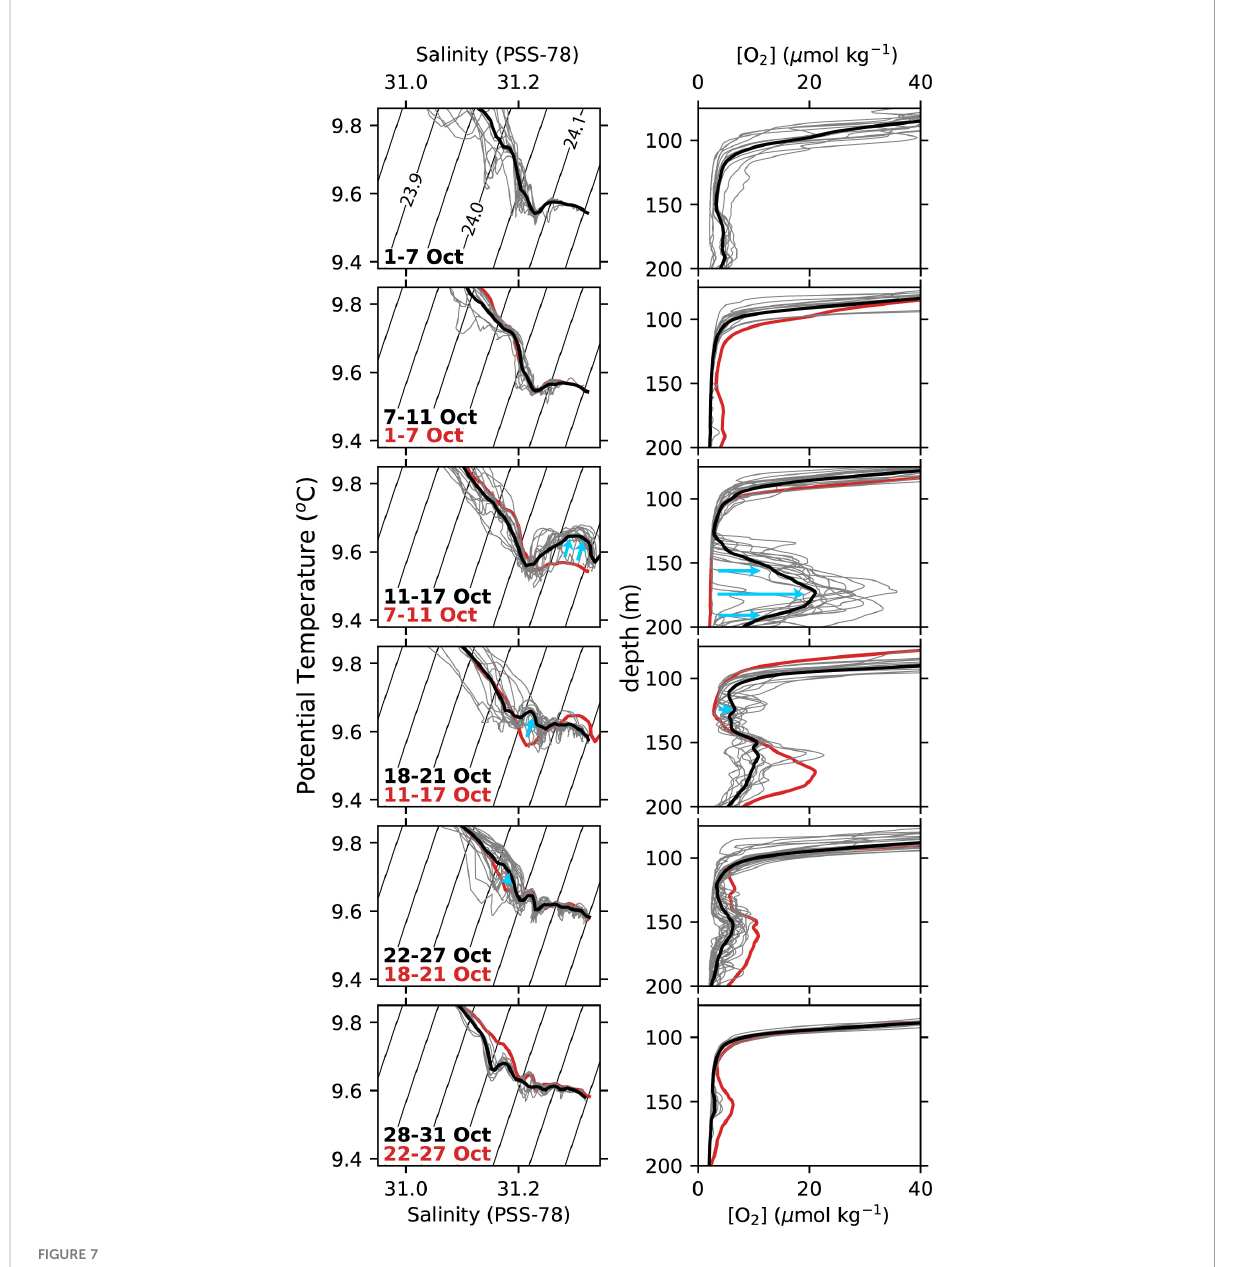
FIGURE 7 Same as Figure 6 but for October